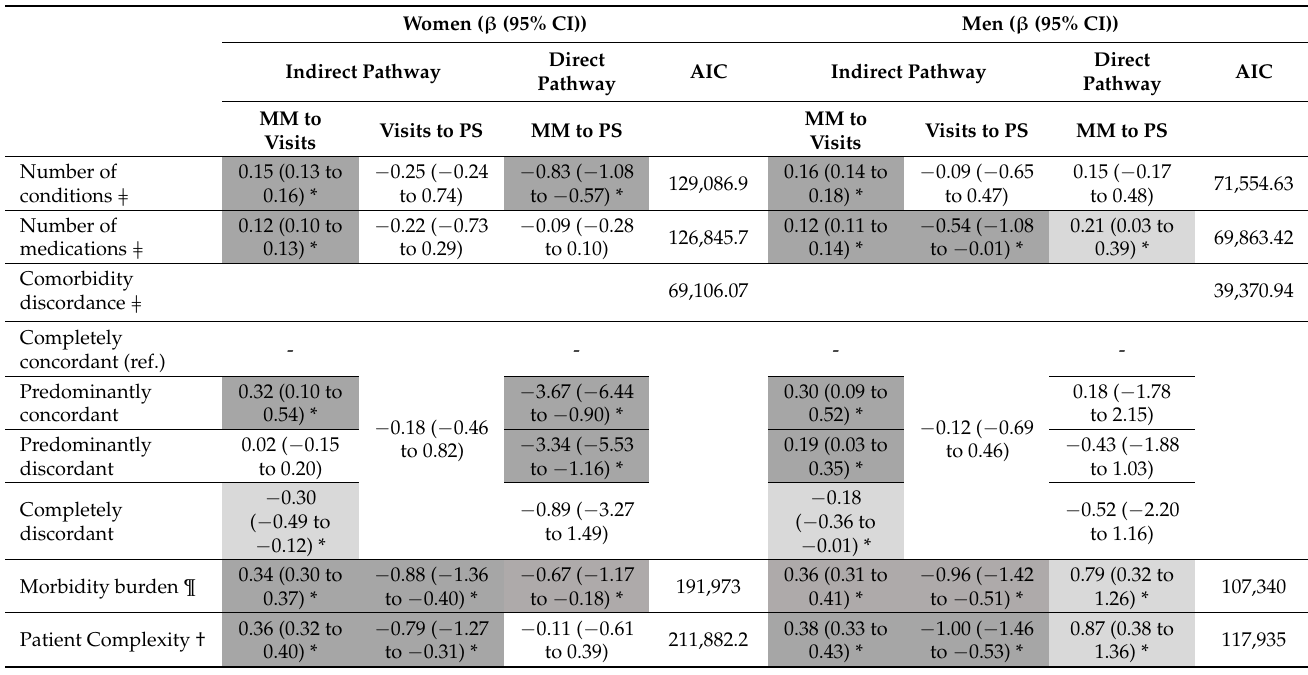
Table 3. Associations between the different measures of multimorbidity, patient safety and number of visits by sex in the final generalized structural equation models